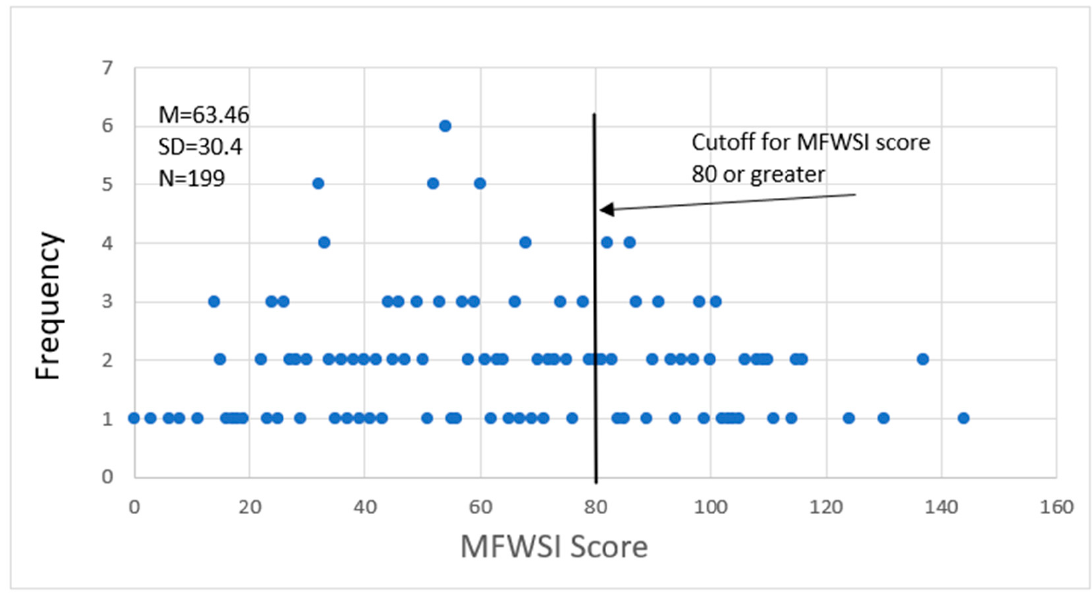
Figure 1. Relative frequencies of respondents’ MFWSI